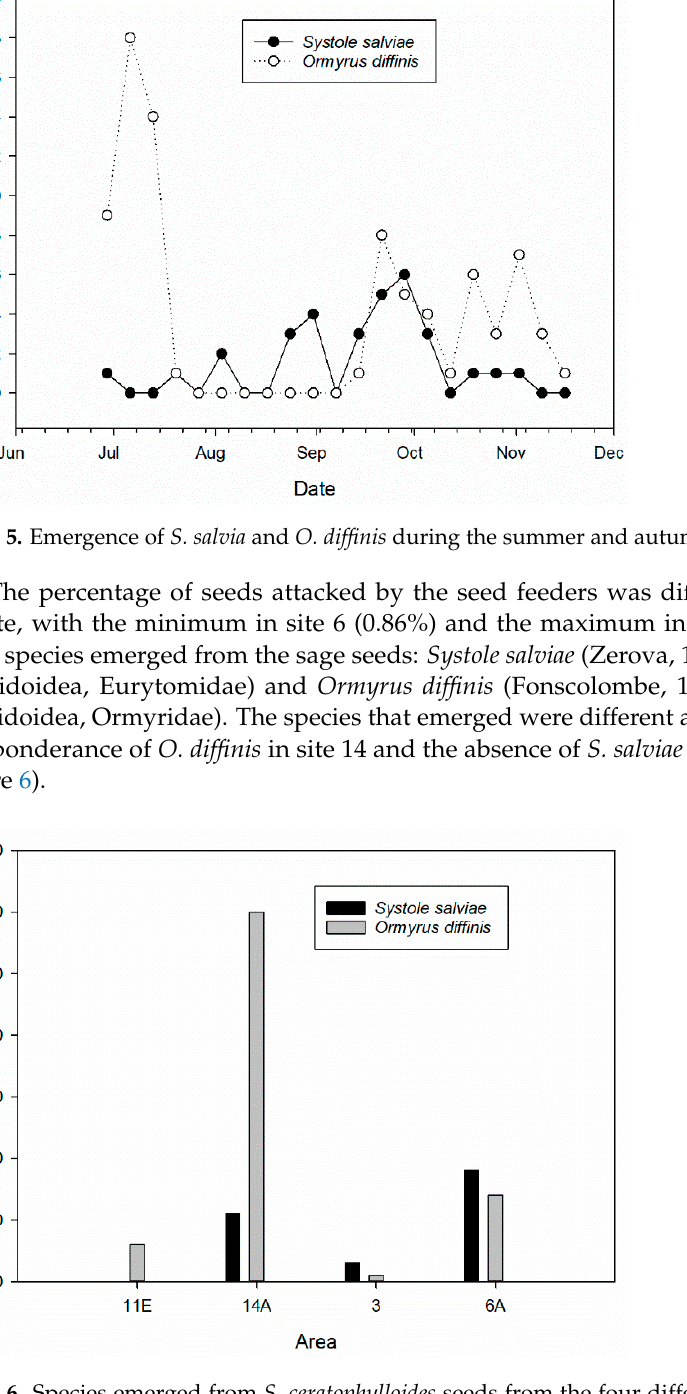
Figure 6. Species emerged from S. ceratophylloides seeds from the four different sites. There were significant differences in the proportion of the two emerged species (Fisher’s exact test = 20.75; N = 113; p < 0.001).